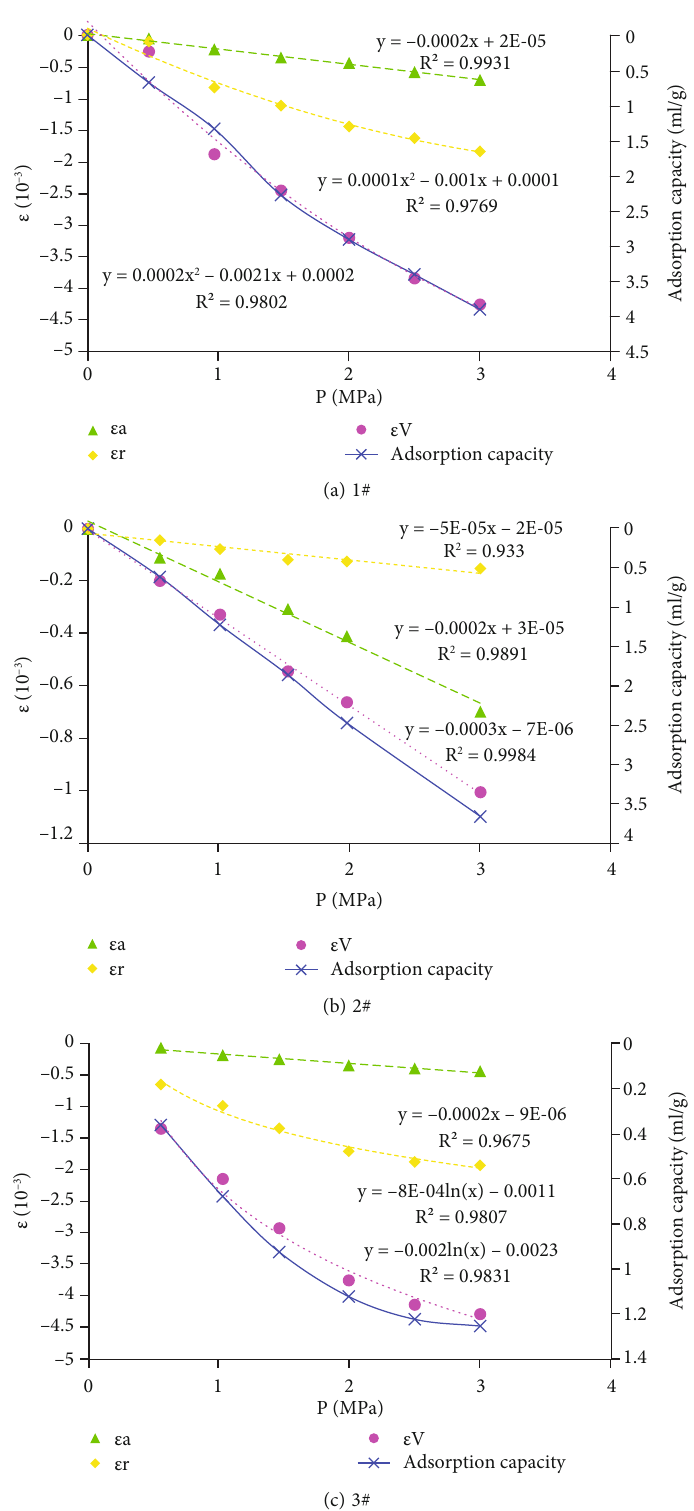
Figure 6: Relationship curve between adsorption capacity, adsorption deformation, and pore